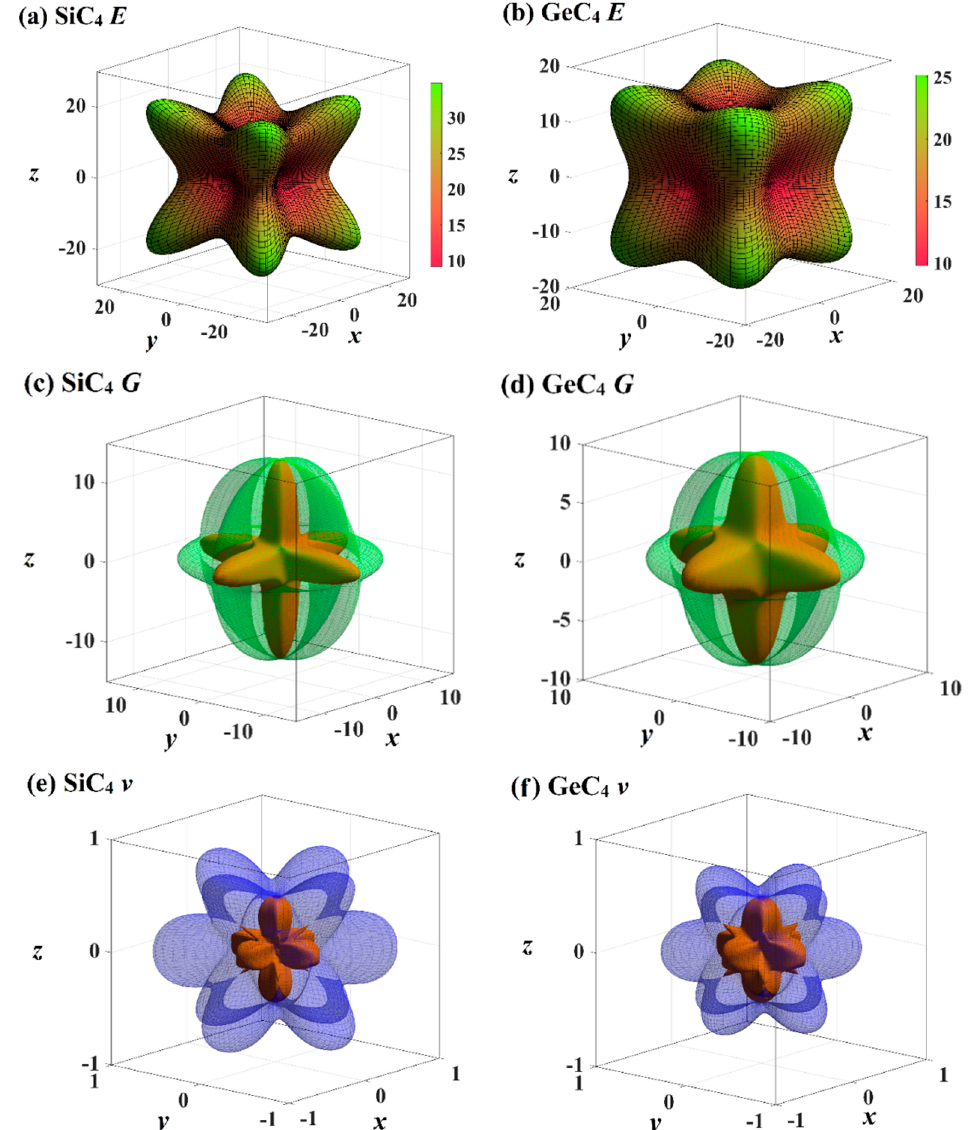
The three-dimensional contour plots of Young’s modulus for ( a ) Si-diamondyne and ( b ) Ge-diamondyne; the three-dimensional contour plots of shear modulus for ( c ) Si-diamondyne and ( d ) Ge-diamondyne; and the three-dimensional contour plots of Poisson’s ratio for ( e ) Si-diamondyne and ( f ) Ge-diamondyne.